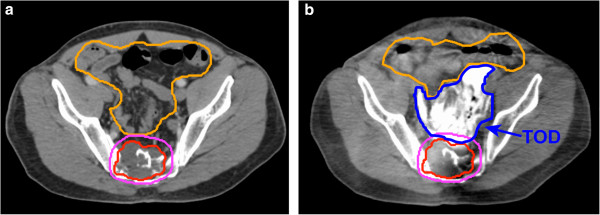
Axial imaging of a sacral chordoma treated to 2400c Gy. (a) Baseline computed tomography (CT) scan revealing pelvic sacral tumor target adjacent to bowel at S2-4. (b) Cone-beam CT confirming temporary organ displacement (TOD) bowel. TOD is well visualized as a hyperdense region (dark blue) between the planning target volume (pink) and bowel (orange). CBCT enables calculation of dose delivered to the critical structures.